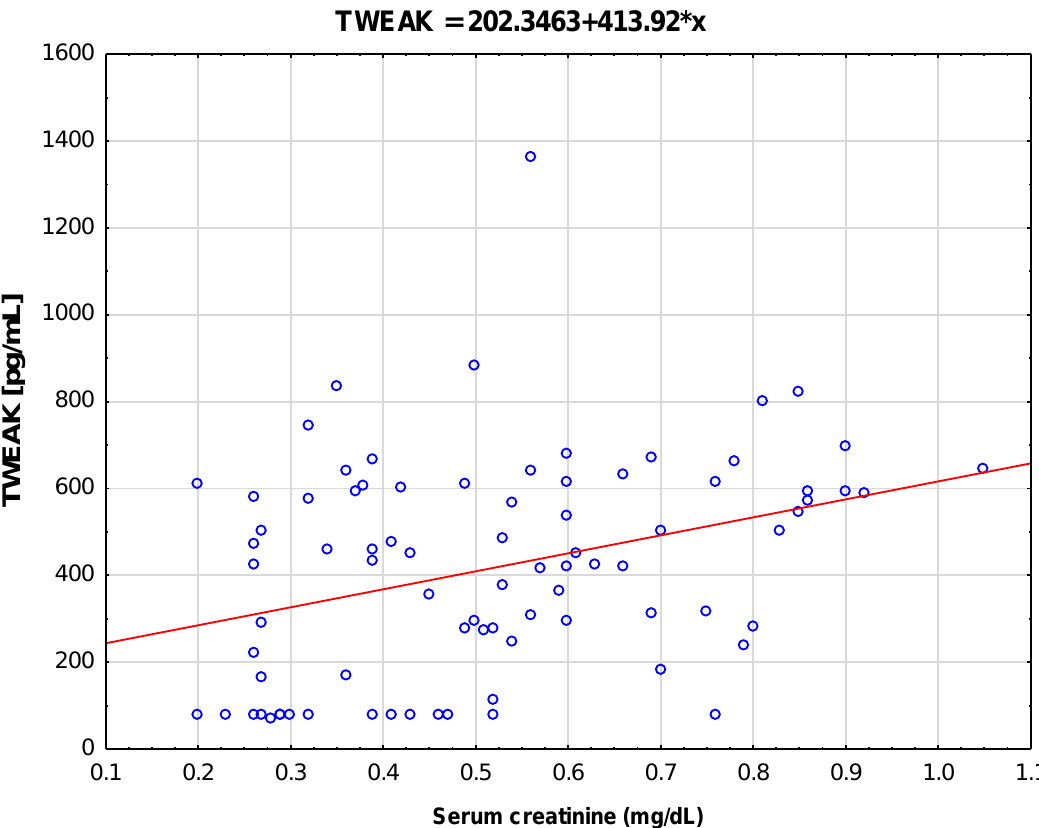
Figure 2. Correlations between serum tumor necrosis factor-like weak inducer of apoptosis (TWEAK) and serum creatinine levels in the study group (B). Table 2. Receiver Operating Characteristic (ROC) analyses for TWEAK, uMCP-1, MCP-1/cr., uRANTES, RANTES/cr. levels in ( A ) children with SFK among all examined children, and ( B ) in children with impaired renal function (albuminuria and/or decreased eGFR <90 mL/min/1.73 m 2 and/or hypertension) among all SFK children. ( A